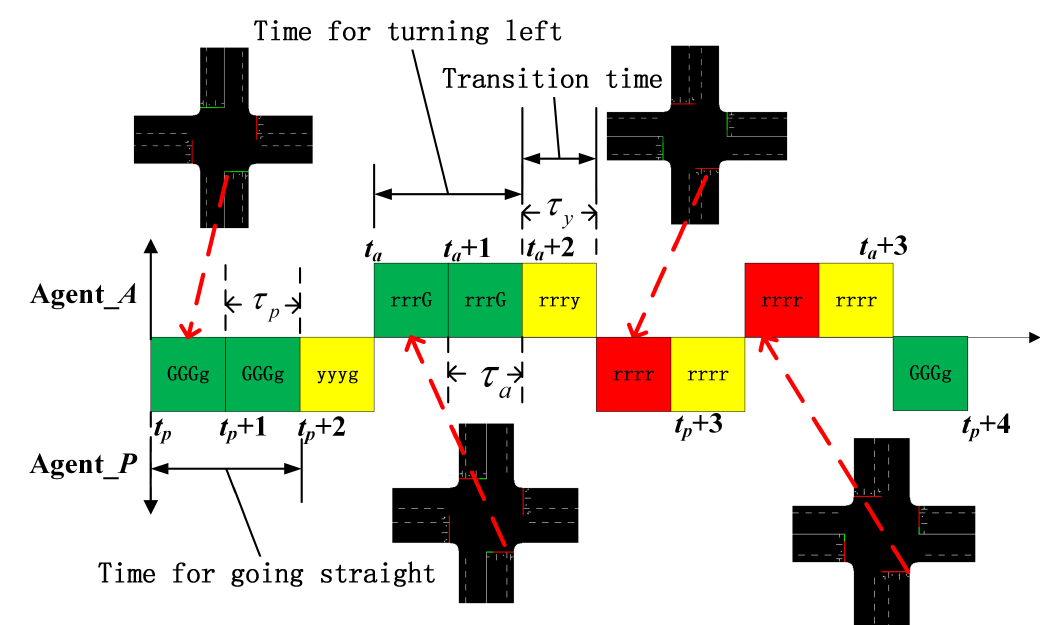
Figure 3. The dual-agent control strategy implemented in the road 2. In the time axis (the horizontal axis), the green, red, and yellow rectangle indicates the green, red, yellow signal in road 2,